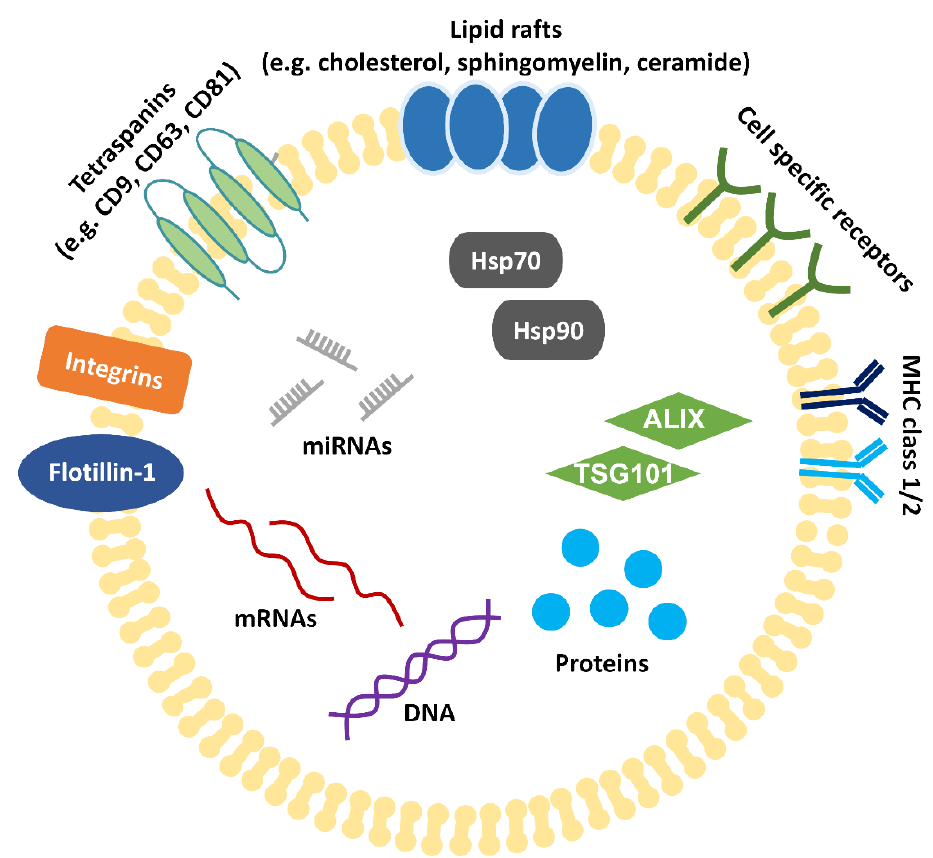
Figure 2. Structure of exosomes. Exosomes have a lipid bilayer membrane composed of lipid raft constituents, tetraspanins (such as CD9, 63 and 81), and proteins (such as integrin, cell specific receptors, MHC class I and class II, and flottilin-1). Exosomes contain cellular components such as proteins, DNA, mRNAs, miRNAs, proteins associated with MVB formation (ALIX, TSG101), and heat shock proteins (Hsp70, Hsp90).